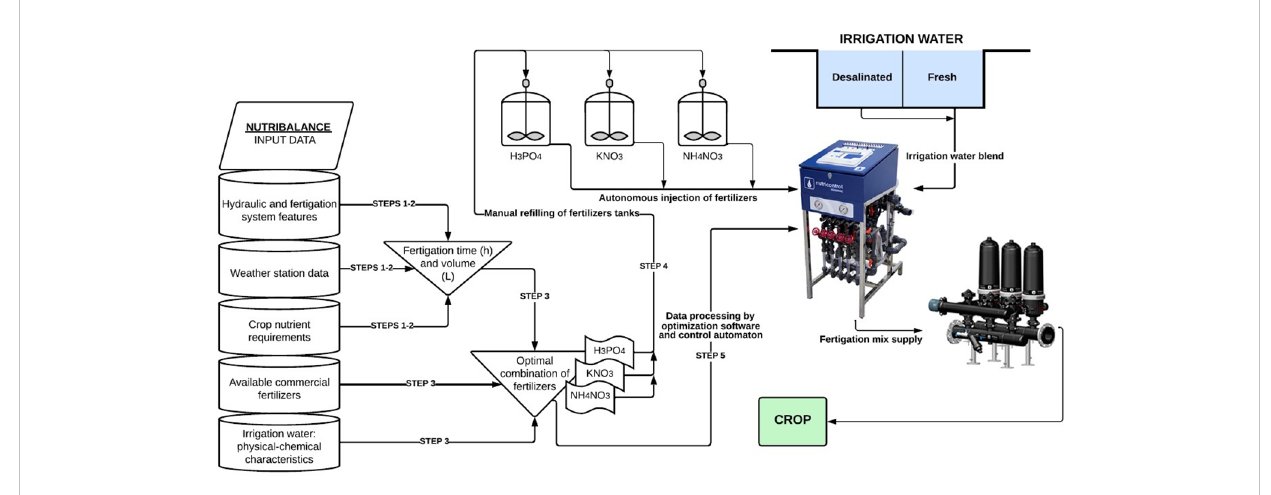
FIGURE 2 Outline and work fl ow of the experimental